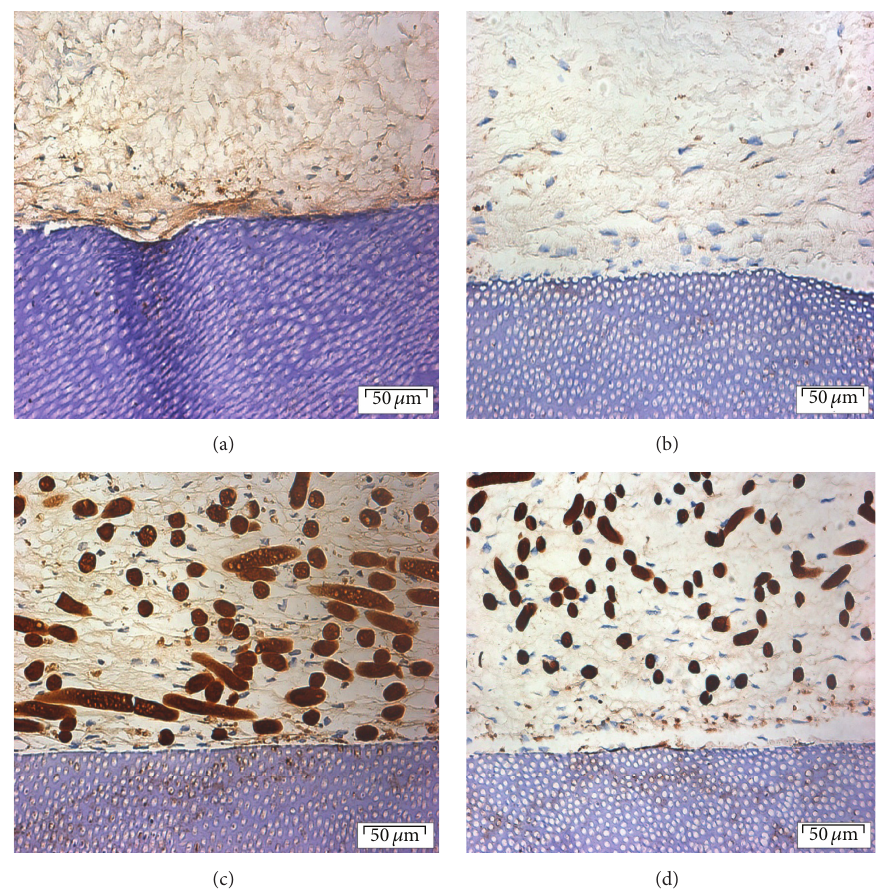
Figure 5: Periostin expression in (a) collagen-spheroids-dentin, (b) collagen monolayer fibroblast-dentin, (c) PGA-spheroid-dentin, and (d) PGA-monolayer fibroblast-dentin cultures after 20 days. Original magnification × 40 (scale bar = 50 𝜇